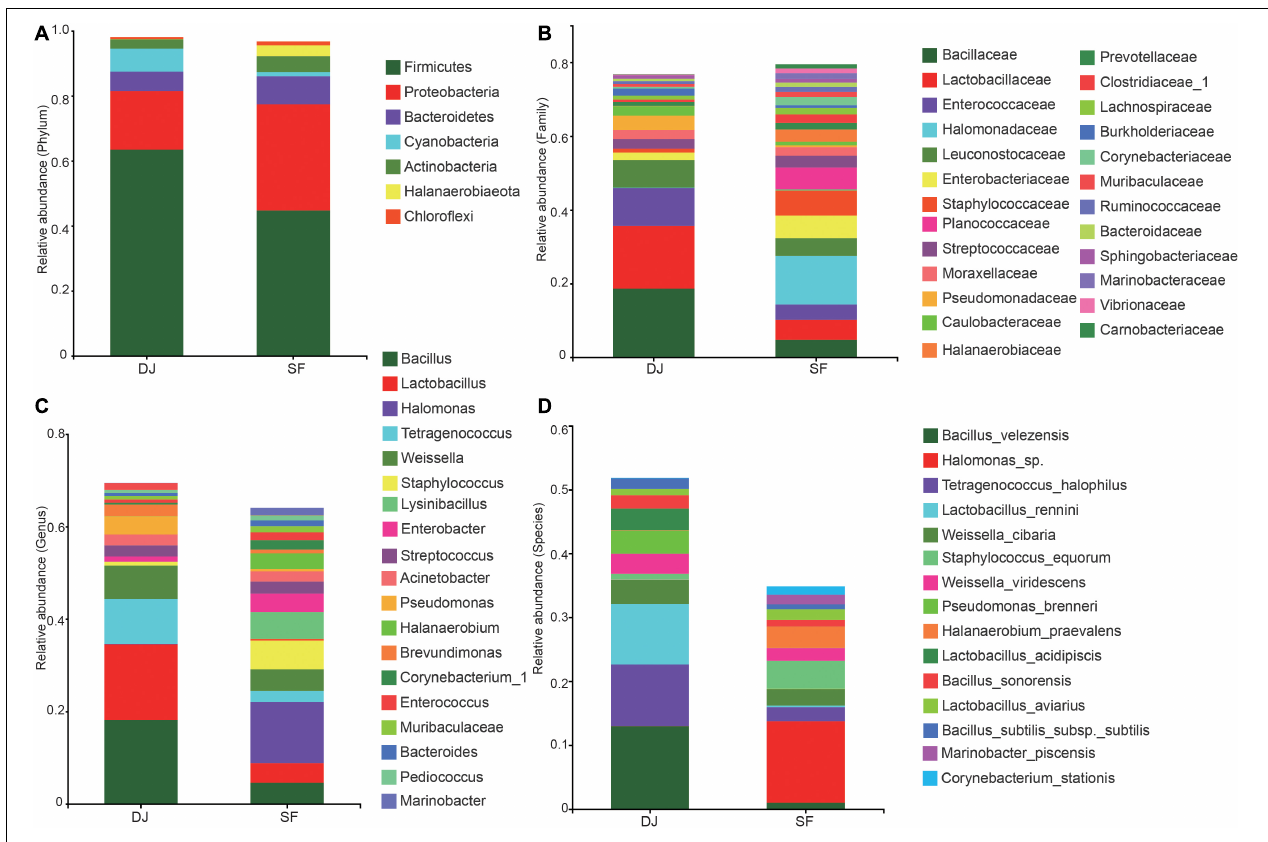
FIGURE 4 | Relative abundance of the bacterial community at the phylum (A) , family (B) , genus (C) , species (D) levels in Dajiang and Sufu. Phyla, family, genus, and species with proportions less than 1% are not